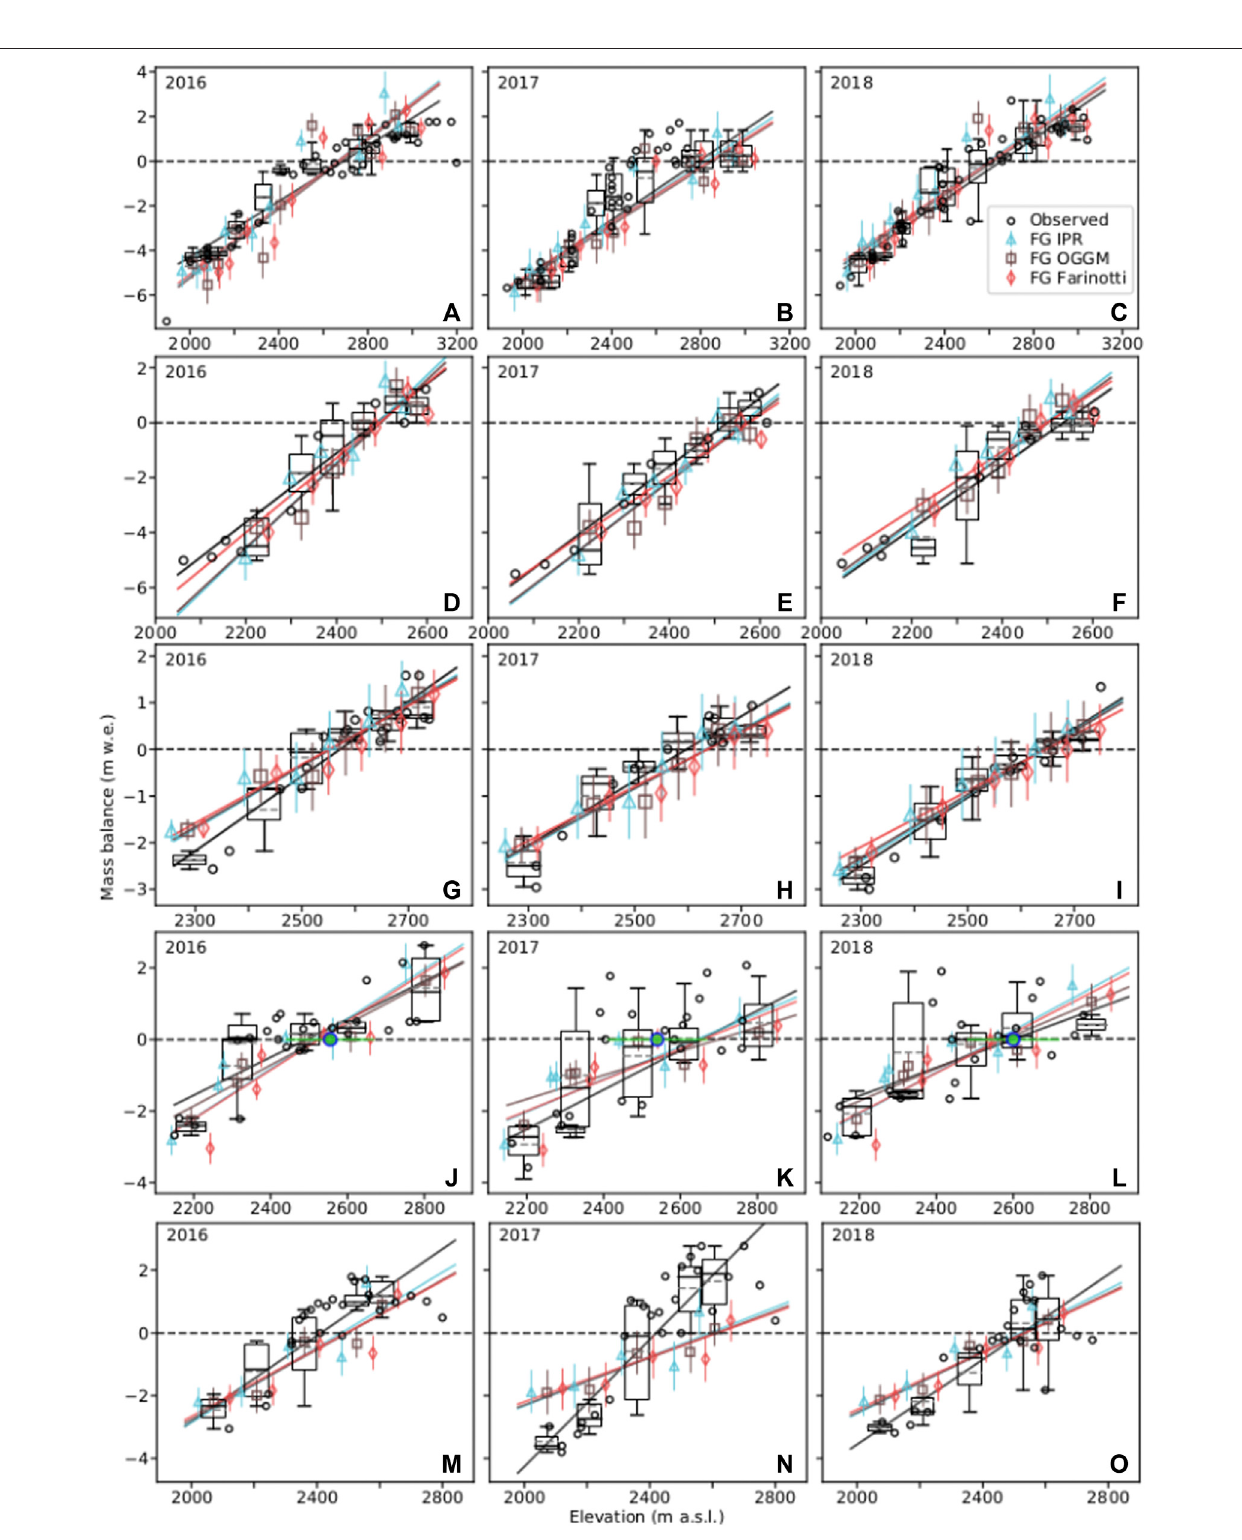
FIGURE8| Observedand modeled( fl uxgate, FG) b a forConrad (A – C) ,Illecillewaet (D – F) , Kokanee (G – I) ,Nordic (J – L) and Zillmer (M – O) glaciersfor2016,2017 and 2018. Balance gradients are fi t with linear functions. Boxplots represent glaciological b a observations for each fl ux bin with 95% con fi dence interval (whiskers), IQR range (box), median (black line) and mean (dashed grey line). Colored error bars represent modeled b a for each fl ux bin.The ALS survey for Zillmer Glacier in 2017 occurred 74 days later than planned ( Supplementary Figure 3 ).